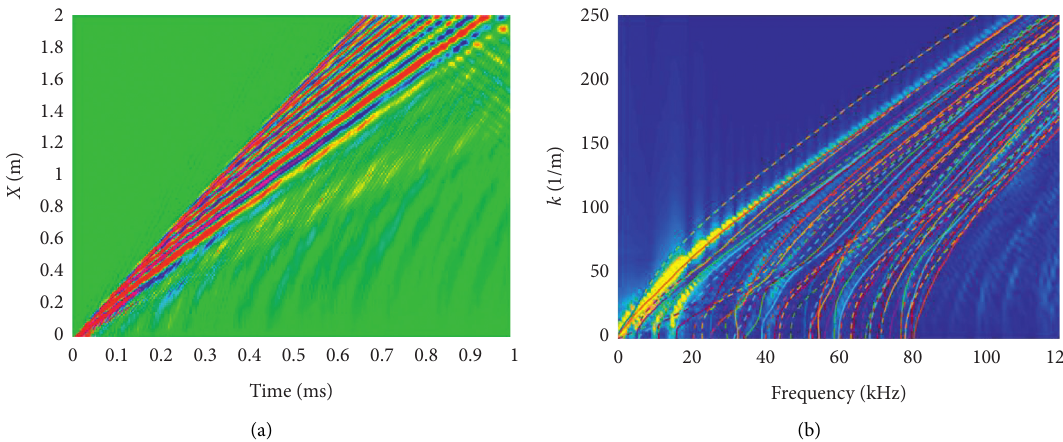
Figure 7: UGW signal from the rail web in (a) time-space domain and (b) wavenumber-frequency domain compared with theoretical dispersion